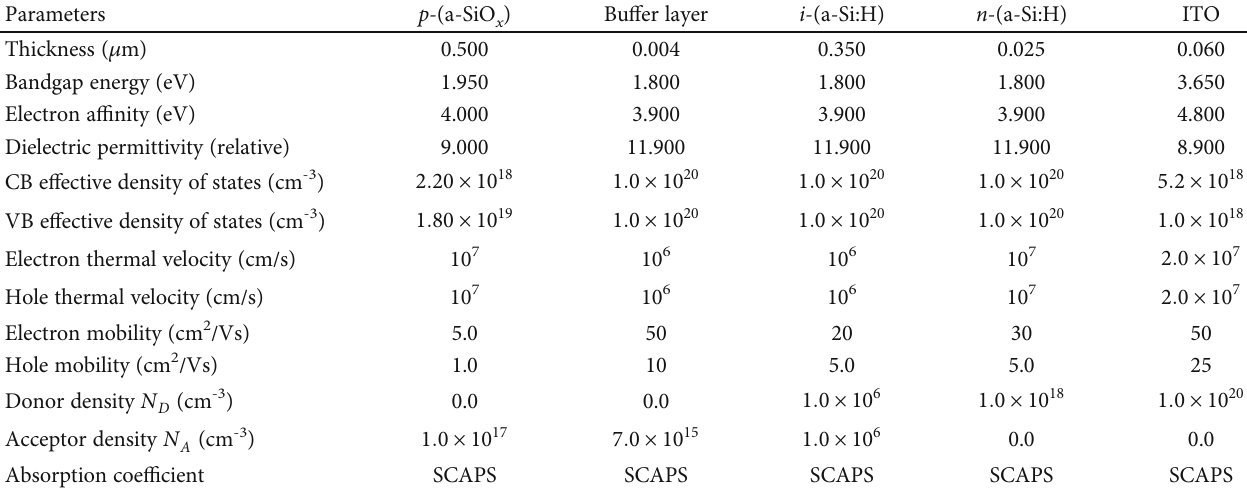
Table 1: Input parameters in SCAPS-1D.